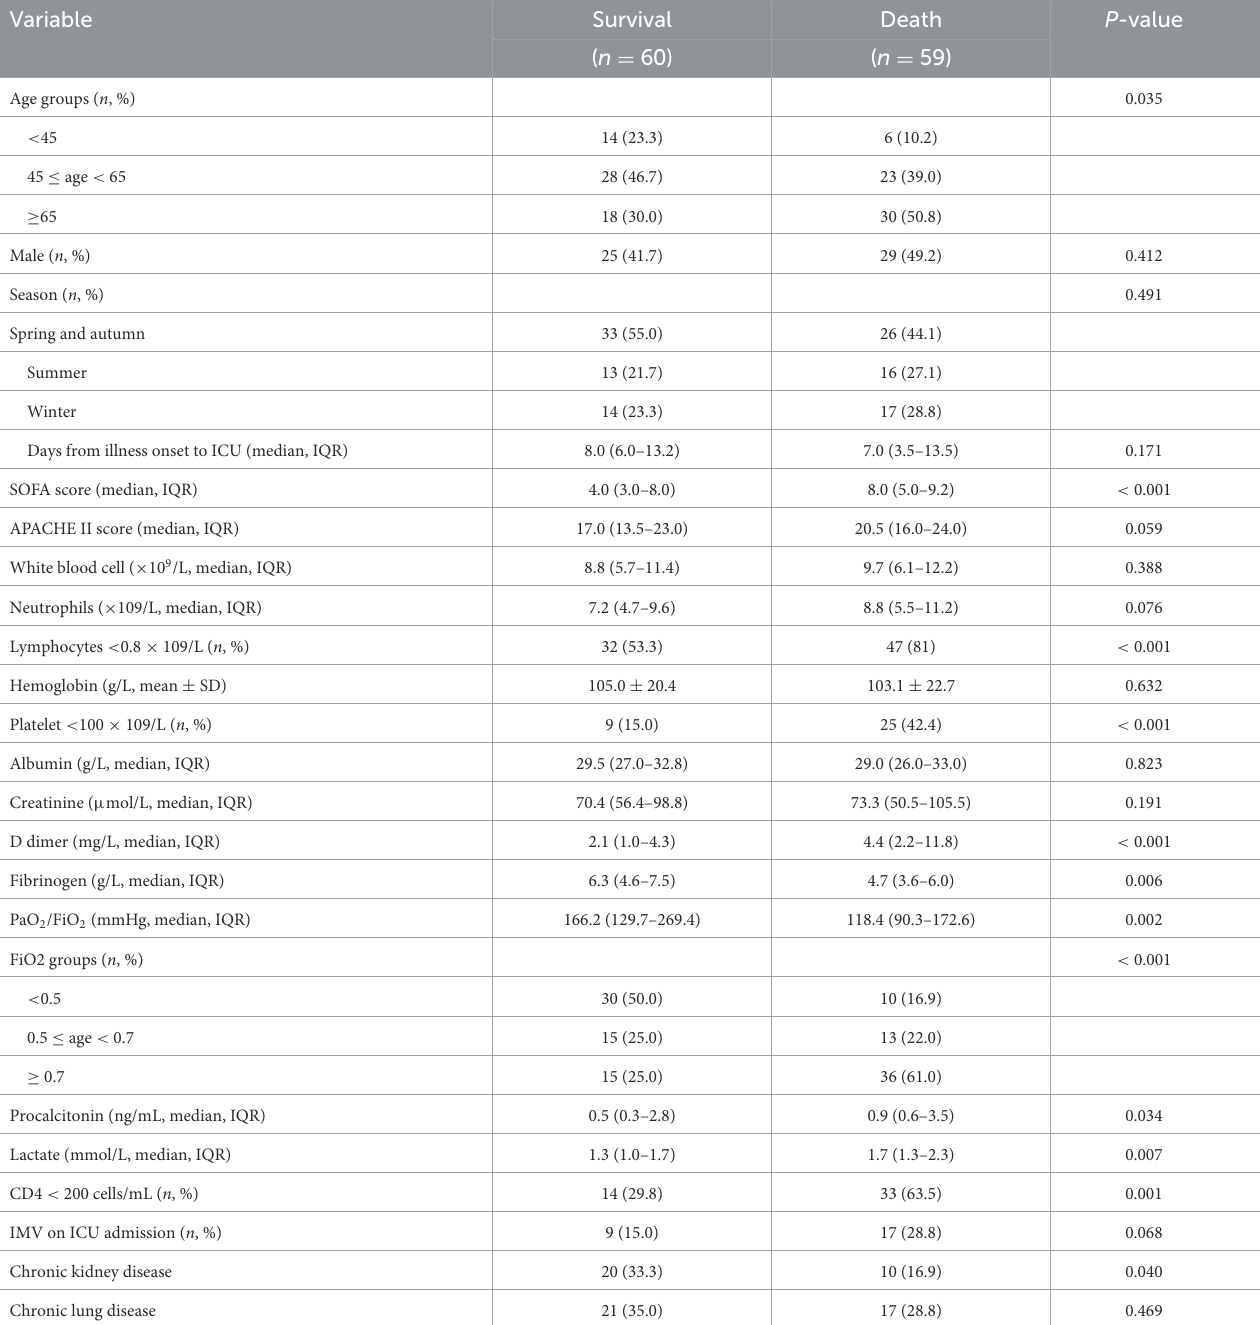
TABLE 3 Comparison of clinical characteristics between survival and death immunocompromised patients with severe community-acquired pneumonia. Variable